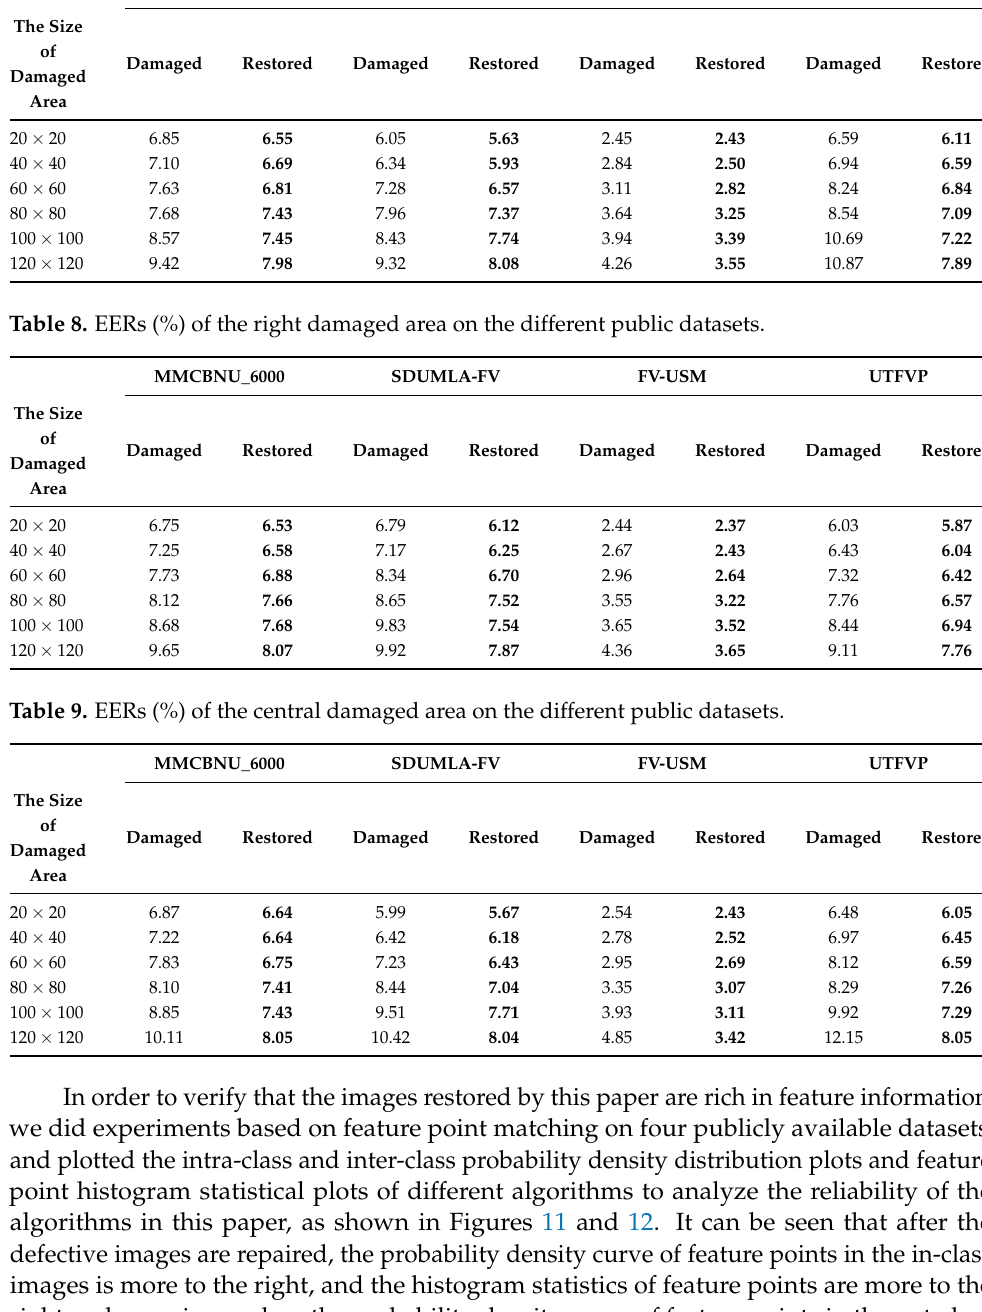
Table 7. EERs (%) of the left damaged area on the different public datasets.